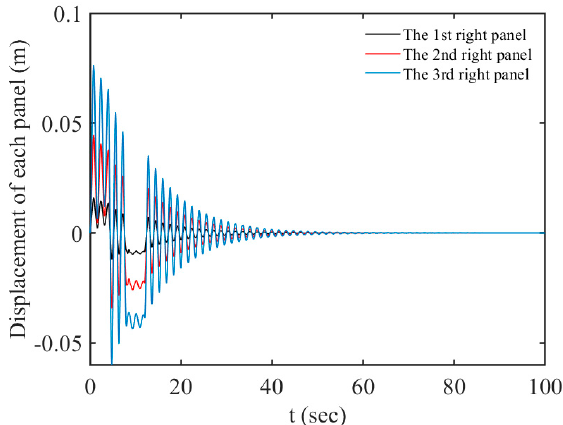
Figure 8. Displacements of the solar arrays under the τ ( k = 50 N · m/rad ).